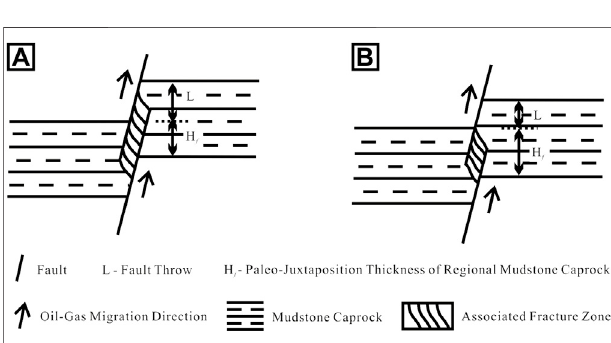
FIGURE4| Diagramofthesealingdegreeofregionalmudstonecaprock damaged byfaultduring thehydrocarbonaccumulationperiod. (A)